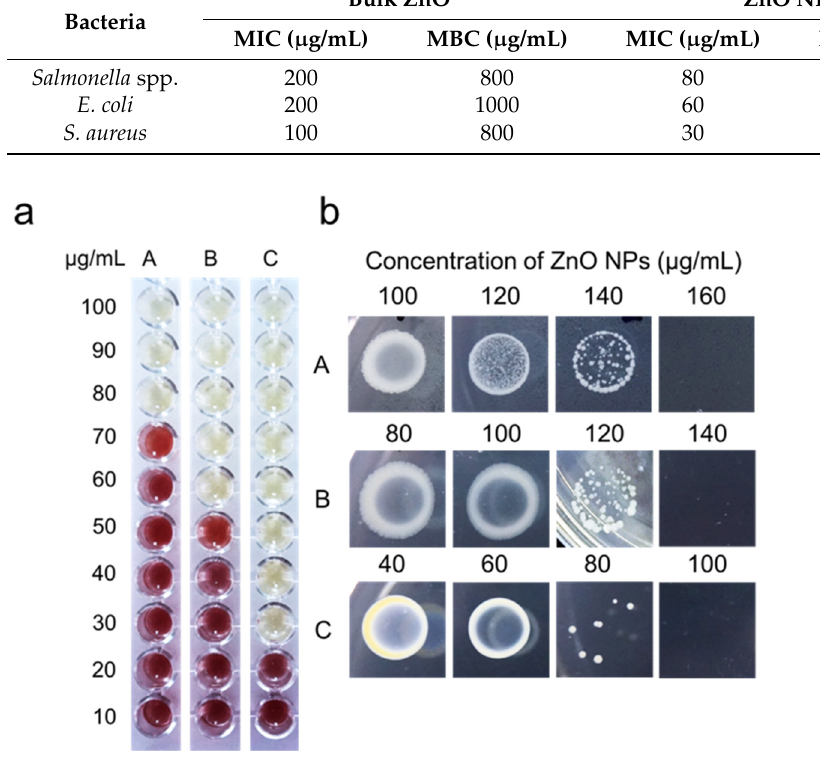
Table 2. Minimum inhibitory concentration (MIC) and minimum bactericidal concentration (MBC) values of zinc oxide nanoparticles (ZnO NPs) and their bulk forms against Salmonella spp., E. coli , and S. aureus . Bacteria Salmonella spp.